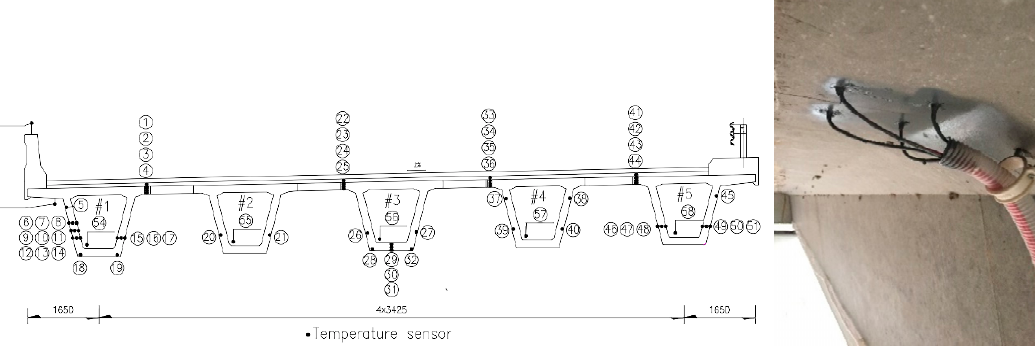
Figure 2. Temperature sensor layout at the midspan.